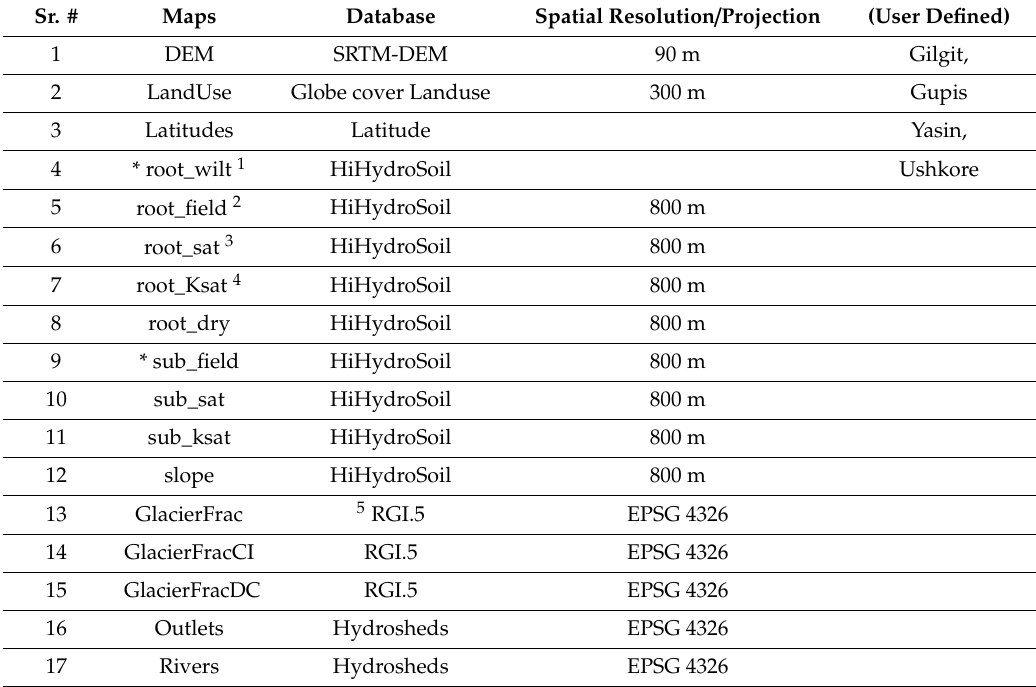
Table 1. Outline of data employed and characteristics of the data available for use in Spatial Processes in Hydrology